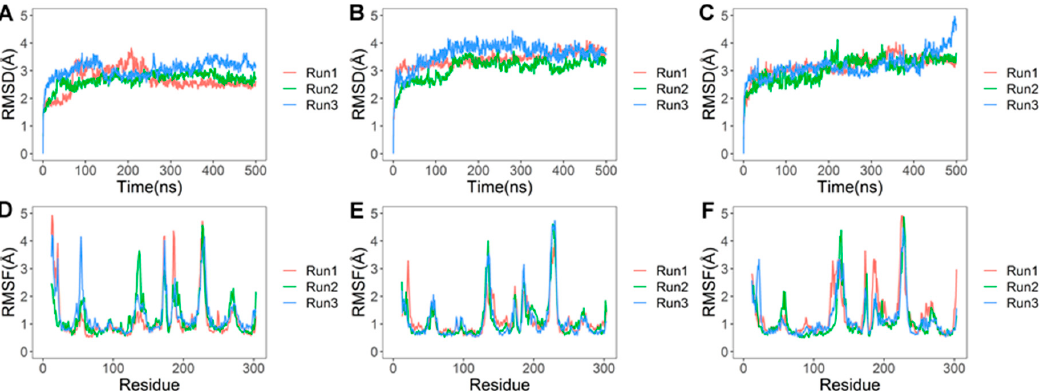
Figure 5. Plots of root mean square deviation (RMSD) and root mean square fluctuation (RMSF) of protein C α atoms extracted from three independent 500 ns simulations of AT1R–peptide complexes. Data from three independent runs are plotted in blue, green, and red colors. ( A ) RMSD of AT1R-LVV-H7 complex, (B ) RMSD of AT1R-AngII complex, ( C ) RMSD of AT1R-LVV-H7-AngII complex, ( D ) RMSF of AT1R-LVV-H7 complex, ( E ) RMSF of AT1R-AngII complex, and ( F ) RMSF of AT1R-LVV-H7-AngII complex.